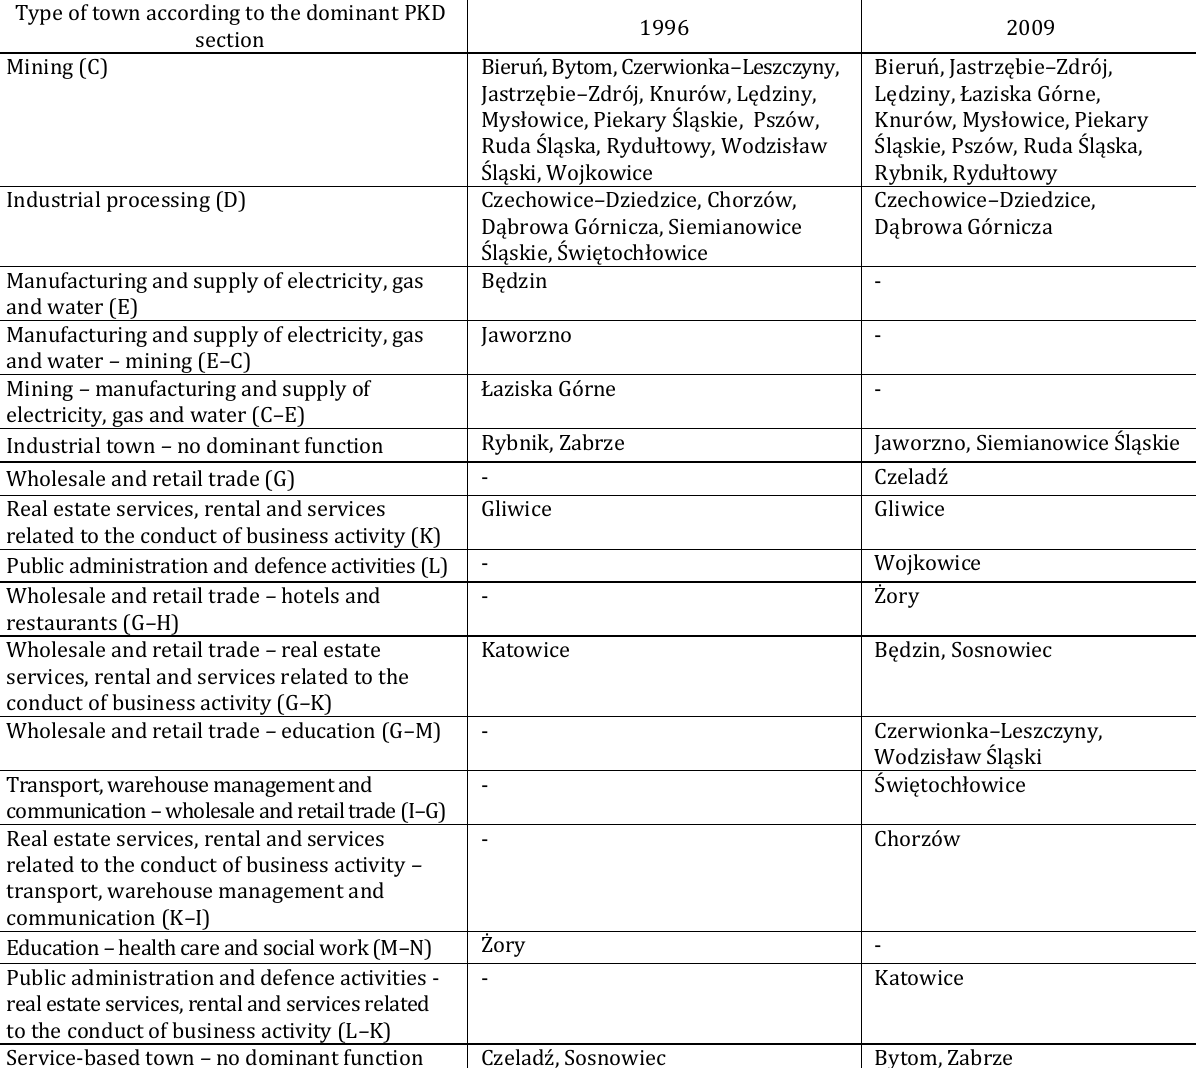
Table 2. Functional specialisation of mining towns in the Silesian voivodeship by exogenous group in 1996 and 2009, divided by individual sections of business activity (author’s compilation) Type of town according to the dominant PKD